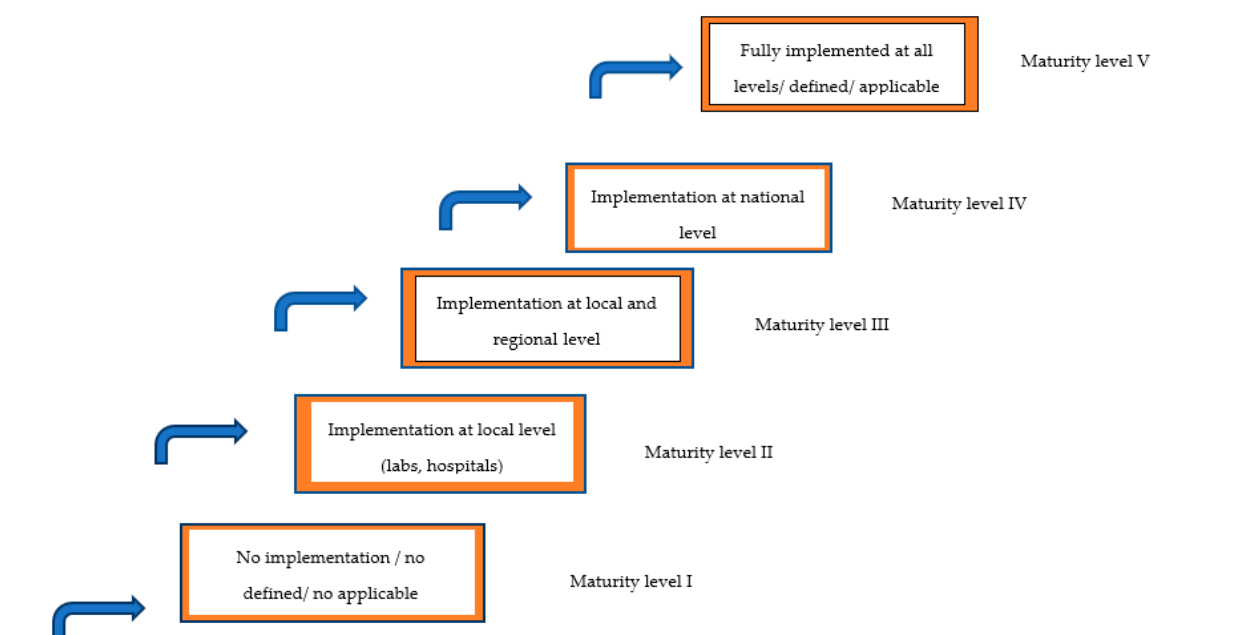
Figure 2. Five maturity levels towards implementing next-generation sequencing (NGS) into healthcare systems.